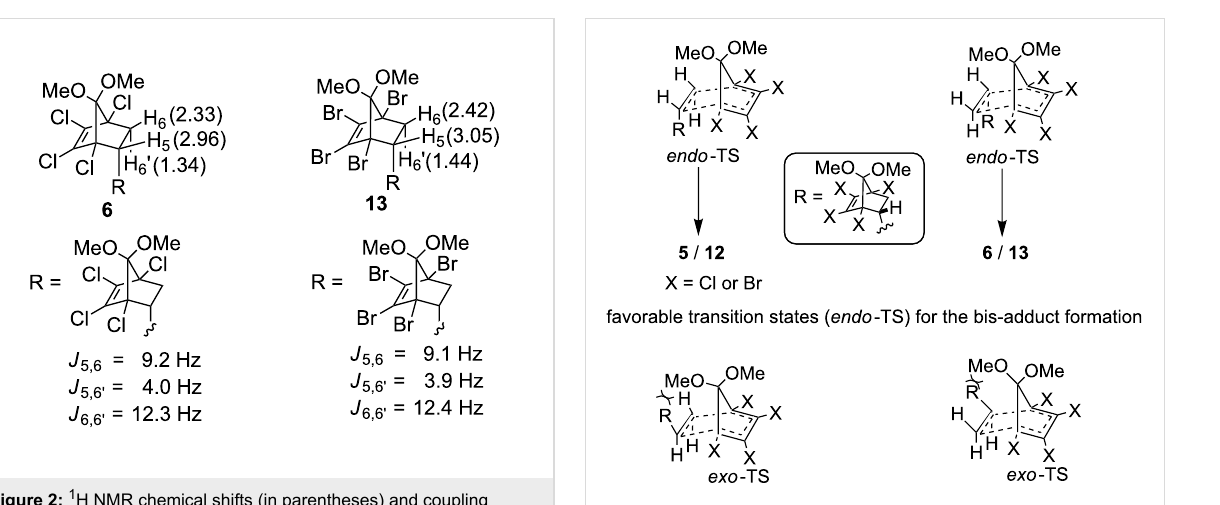
Figure 3: Transition state models for the bis-adduct